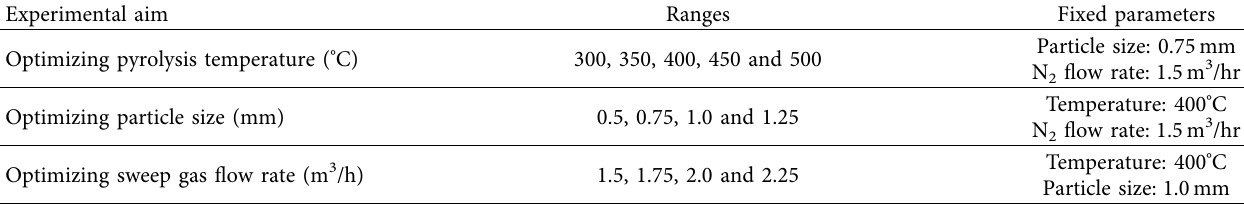
Table 1: Experimental condition.